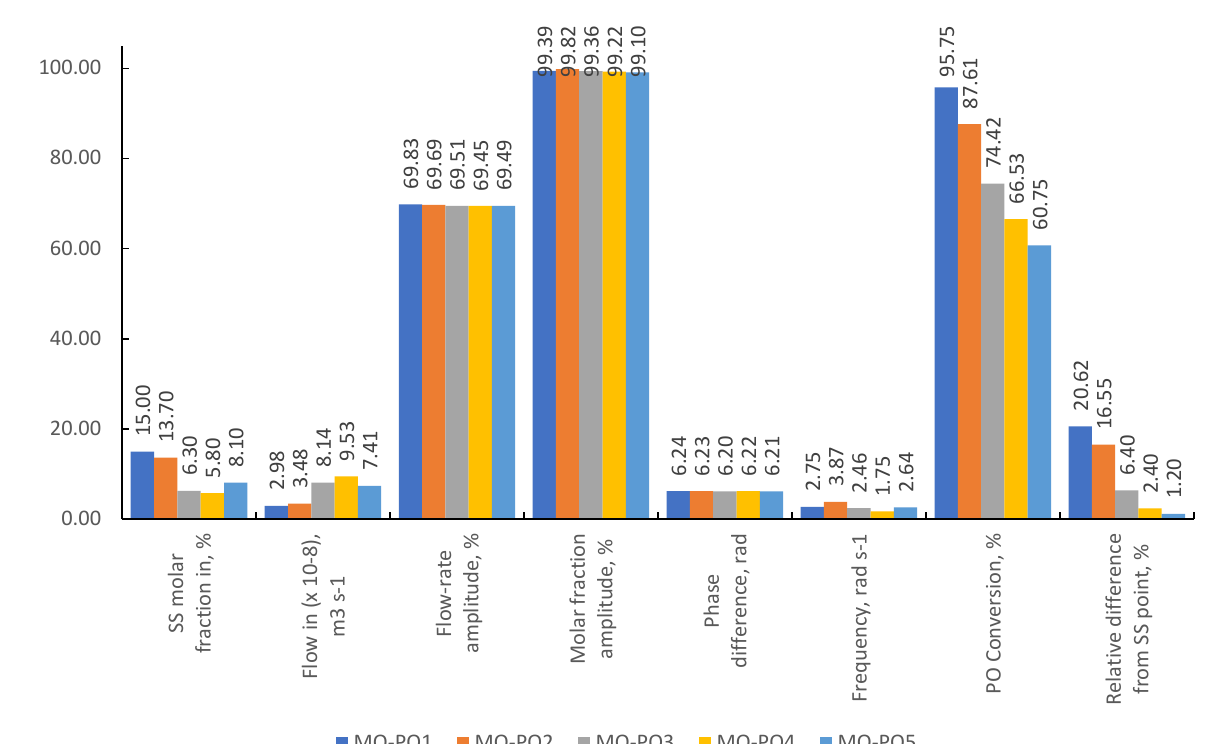
Figure 9. The optimised values of forcing parameters, the acid conversion under forced periodic modulation and the difference from the SS operation for the five points (MO-PO1–MO-PO5) from the Pareto front for Case 5 (simultaneous modulations of the inlet flowrate and the acid molar fraction).